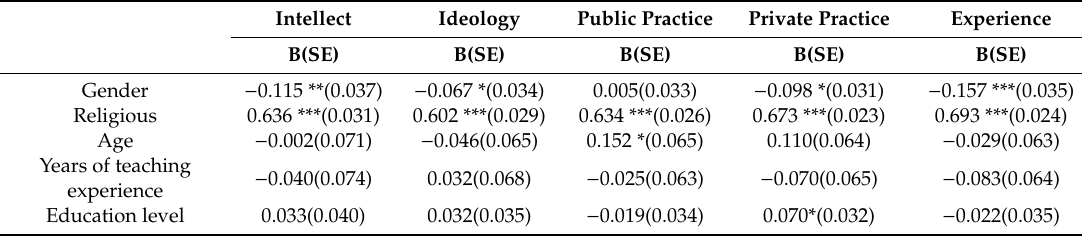
Table A7. Results of the multiple-indicators multiple-causes (MIMIC) model for